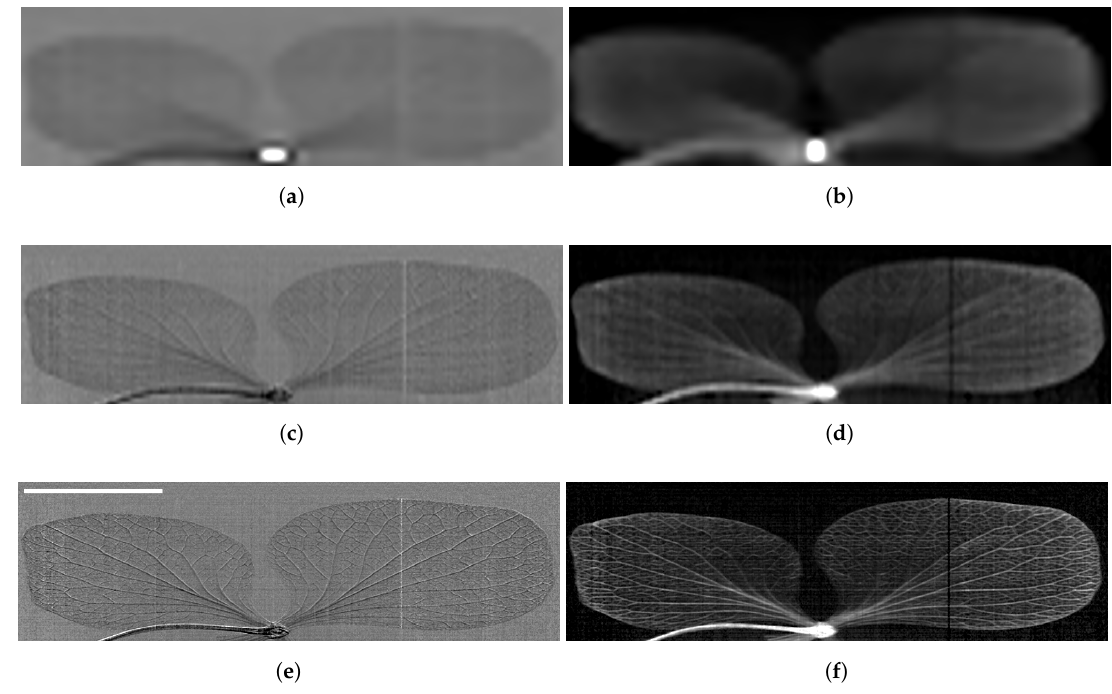
Figure 3. Single-shot X-ray ( a , c , e ) differential phase and ( b , d , f ) dark-field images of a flower obtained through hierarchical data analysis. To overcome numerical instabilities, the raw intensity images were processed by iteratively decreasing binning: ( a , b ) used 50 × 50, ( c , d ) used 20 × 20 and ( e , f ) used 4 × 4. The scale bar in panel ( e ) is 1